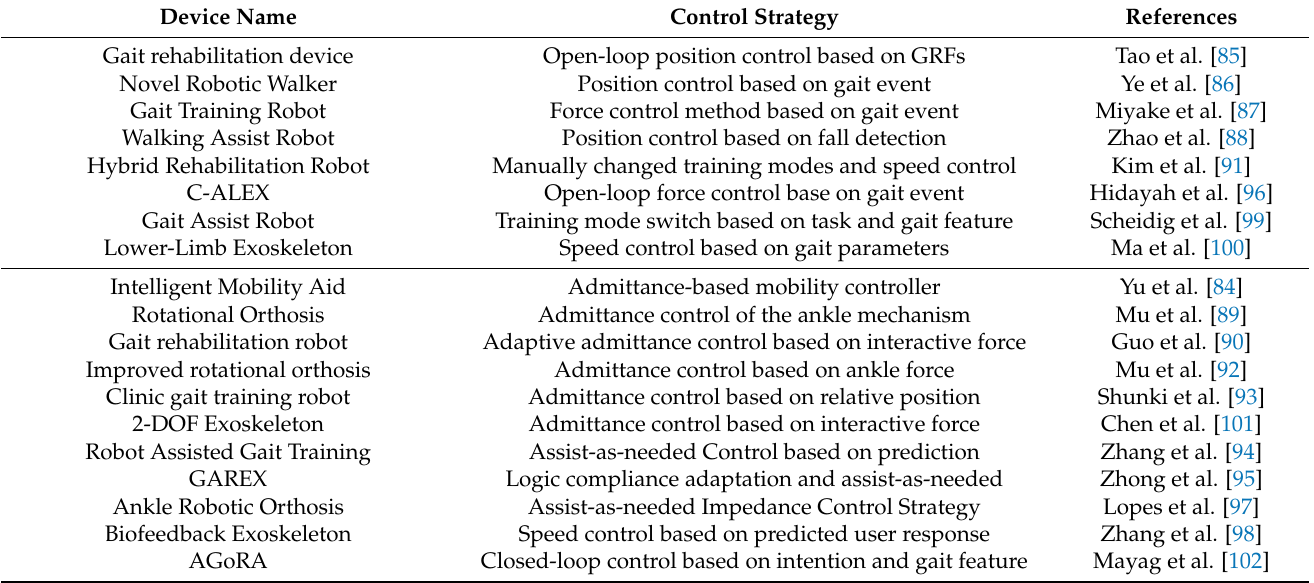
Table 4. Gait training systems and control strategies of each